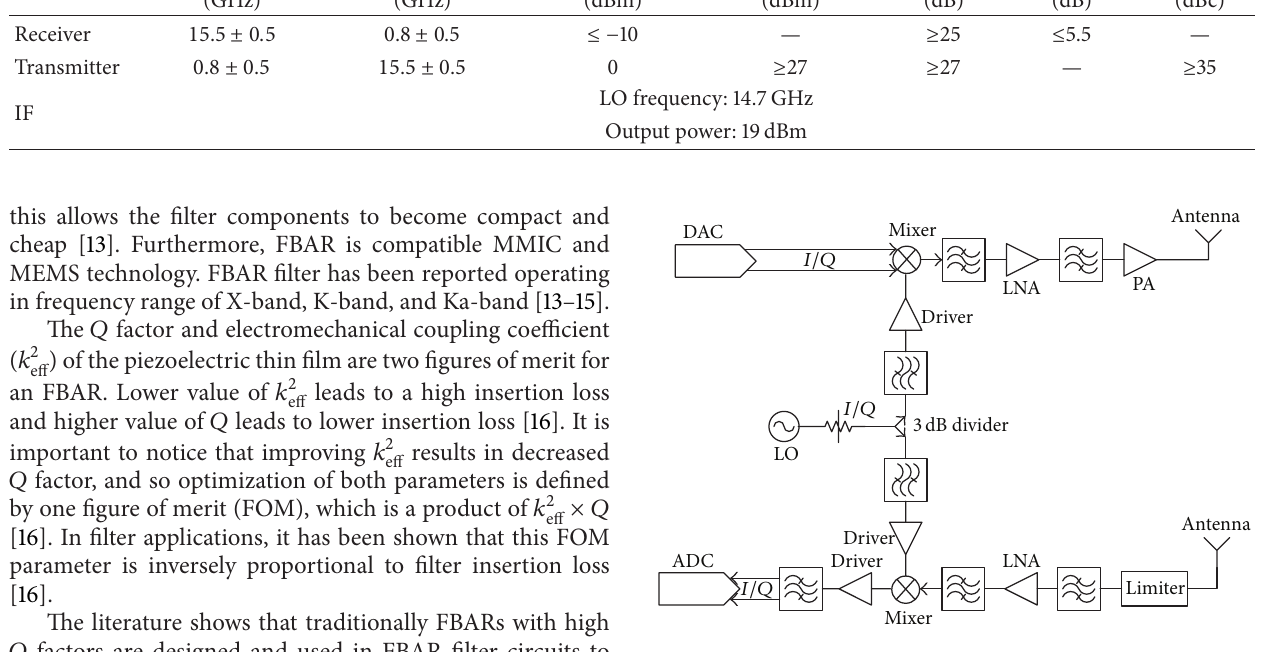
Figure 1: Front-end of Ku-band transceiver [3].